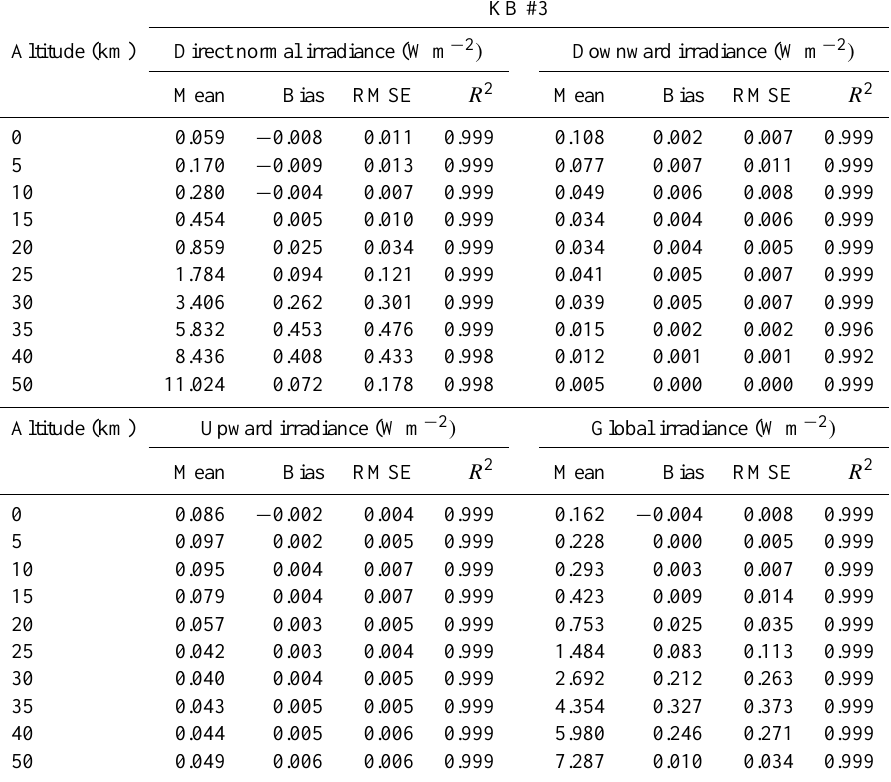
Table 3. Statistical indicators of the performances of the new parameterization for computing the irradiances in Kato band #3 at different altitudes above ground level. Mean is the mean irradiance obtained from the detailed spectral calculations considered as